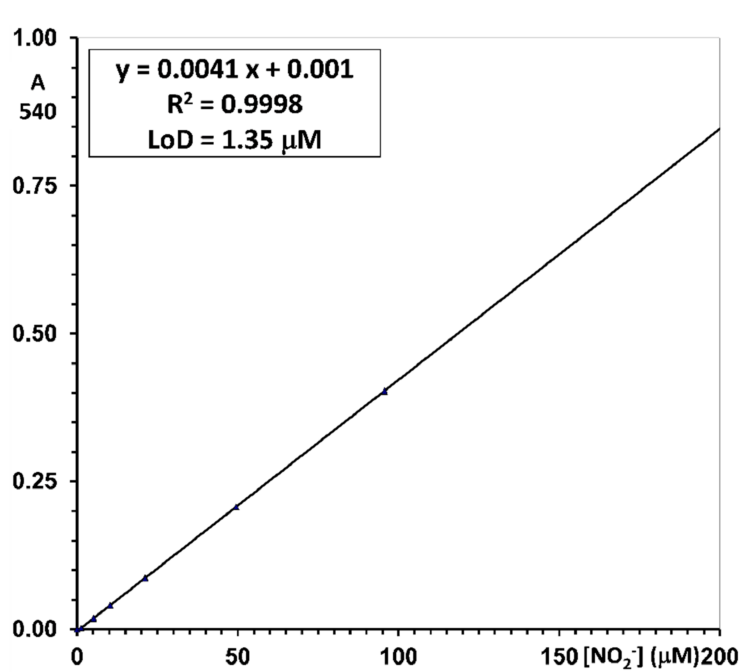
Figure 2. An example of a daily standard curve for nitrite measurement with the reported equation, goodness-of-fit, and Lower Limit of Detection (LLoD). Confidence limits of ± 0.9 µ M are highlighted by the dashed lines. Analytical conditions are described in the Materials and Methods section.